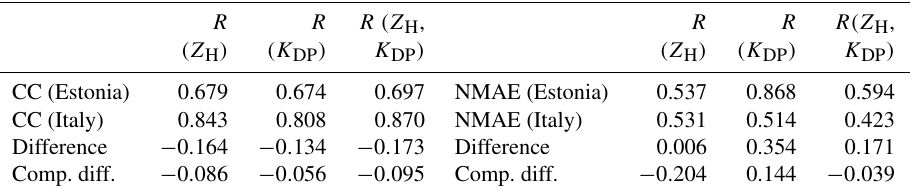
Table 2. Verification of the 1h accumulation QPE products of Estonia and Italy and differences without (“Difference”) and with (“Comp. diff”) compensating for the impact of the temporal sampling. CC and NMAE values are obtained from Tables 3 and 4. Z H is not corrected for attenuation.